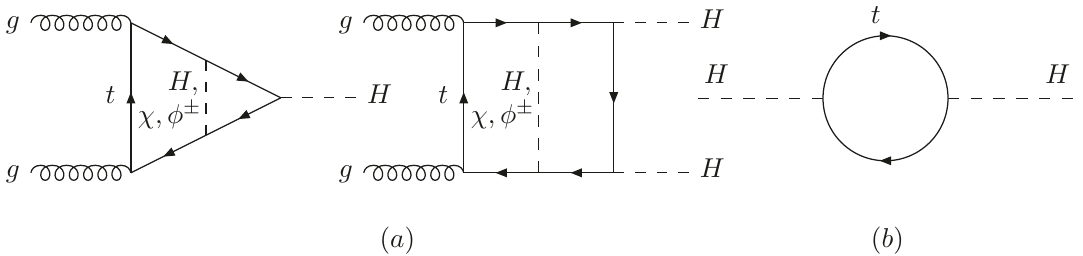
Figure 2 . Typical diagrams contributing to the top-Yukawa-induced electroweak corrections to the effective Lagrangian: (a) vertex corrections, (b) wave-function corrections. The fields χ, φ ± denote the pseudoscalar and charged would-be